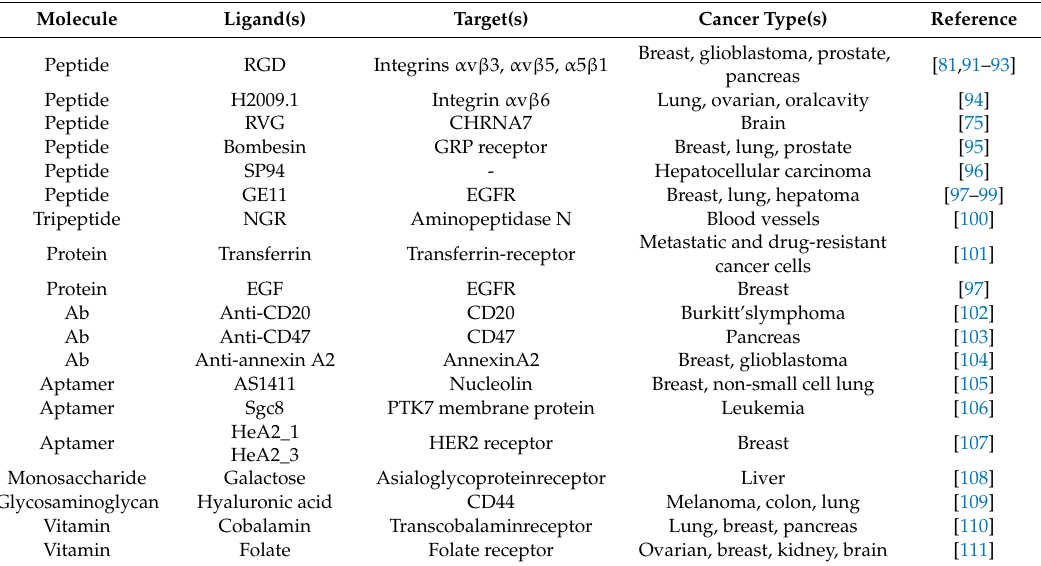
Table 1. List of ligands and related targets in cancer